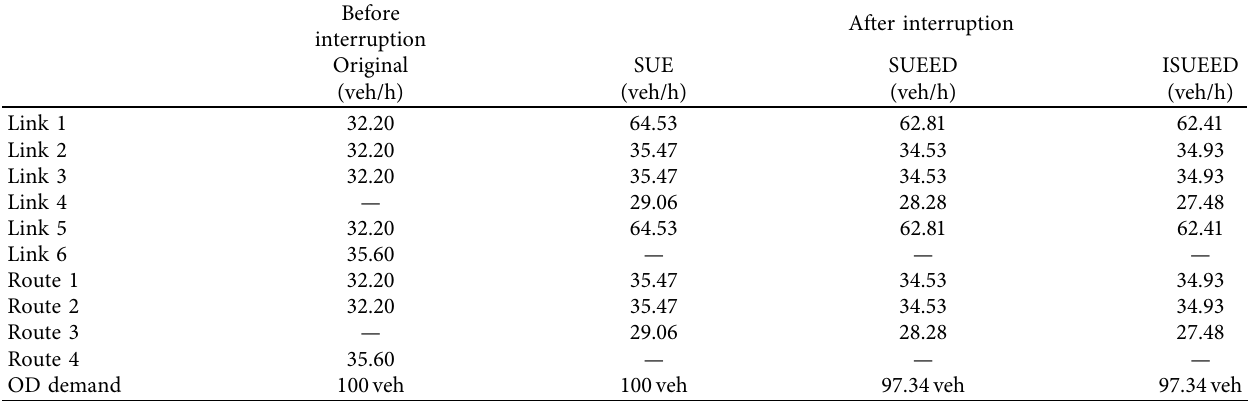
Table 2: The flow of links and routes.